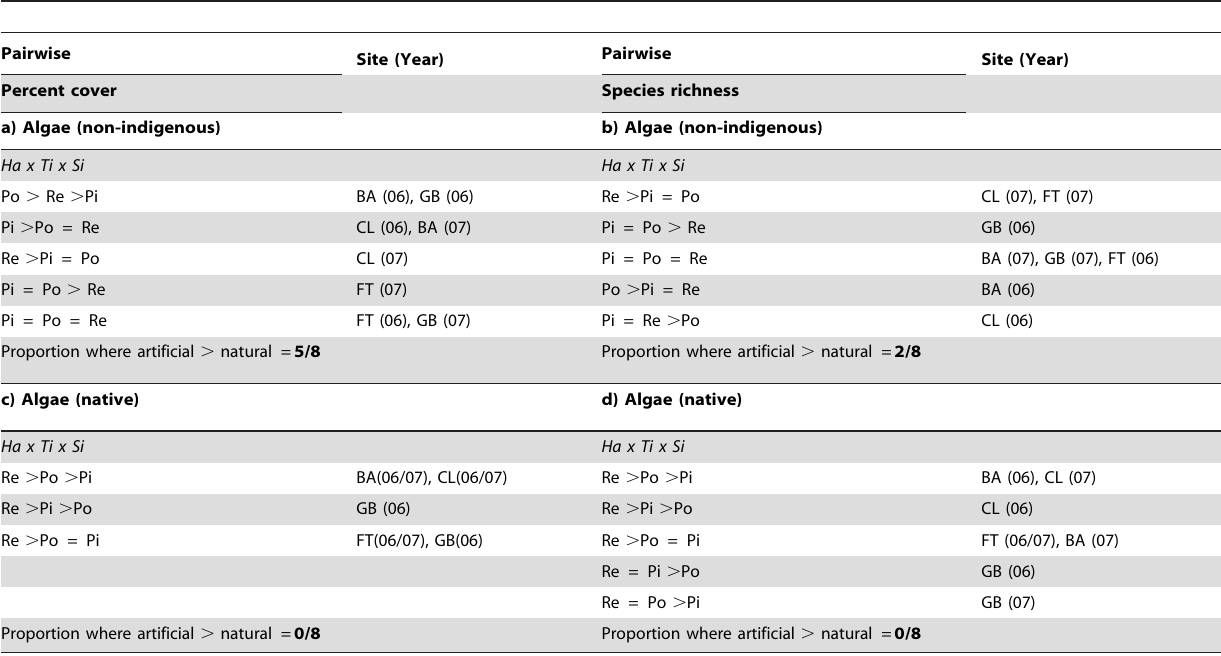
Table 4. Pairwise comparisons of the non-indigenous and native algal species percent cover and richness sampled from artificial and natural